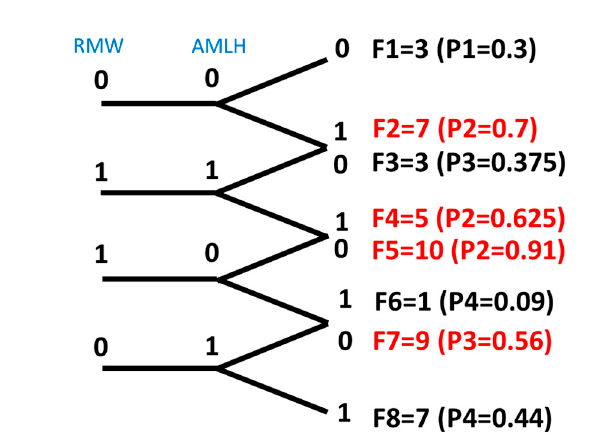
Figure A14. Use RMW and AMLH to forecast the direction of AMLH.